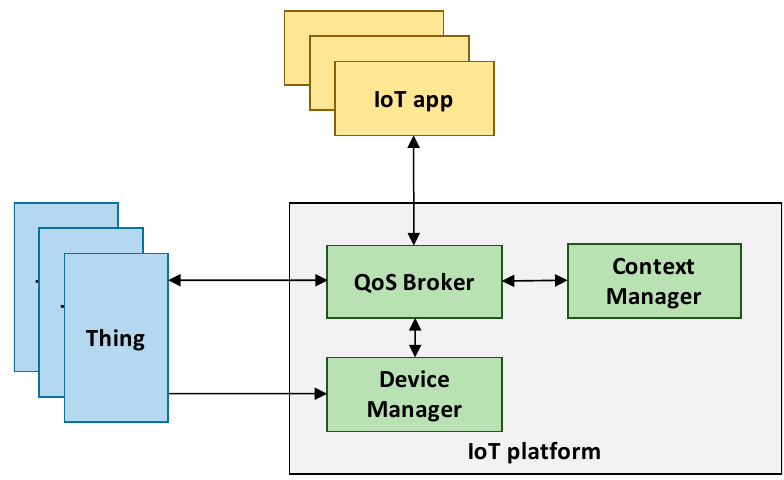
Figure 1. Reference architecture.